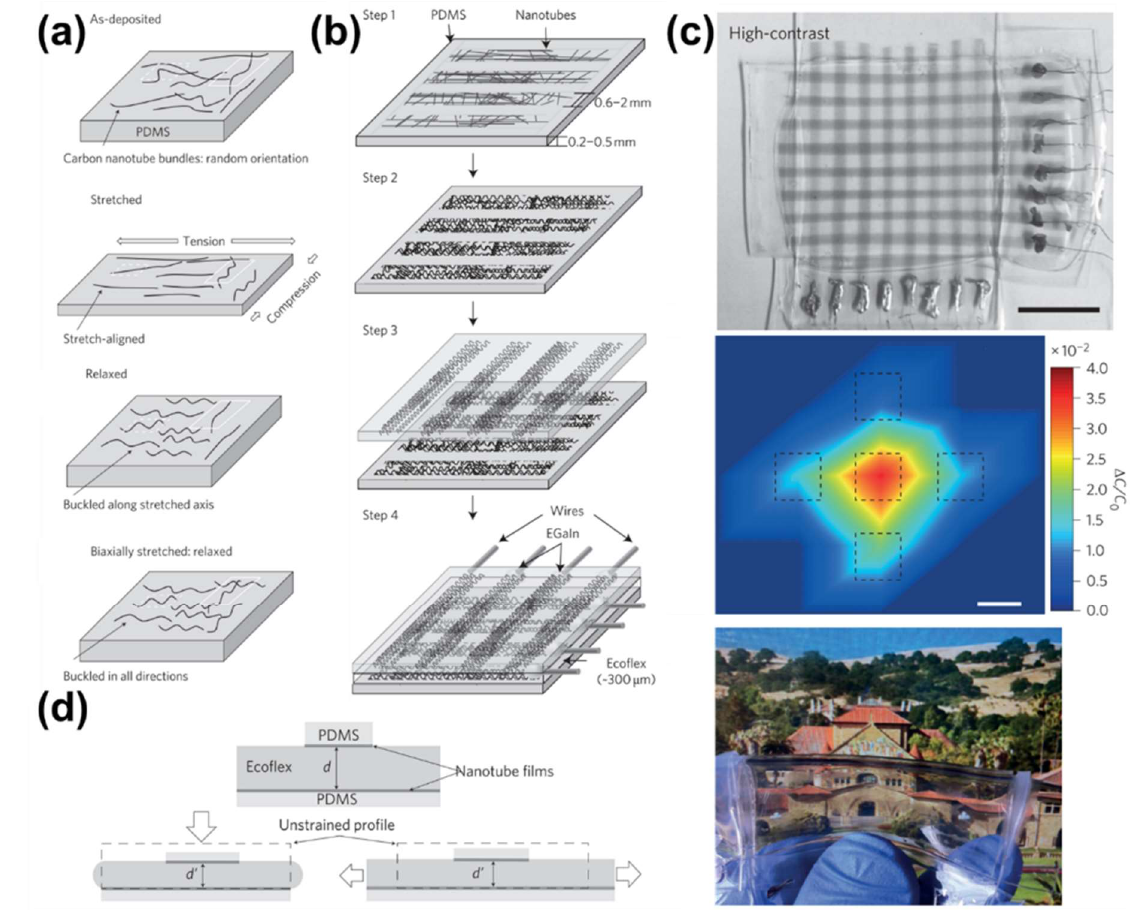
Figure 6. Schematic illustrations of transparent elastic films of CNTs. ( a ) Evolution of morphology of films of CNTs with stretching. ( b ) Processes used to fabricate arrays. Spray-coating through a stencil mask produces lines of randomly oriented nanotubes (step 1). A one-time application of strain and release produces waves in the direction of strain (step 2). A second patterned substrate is positioned (face-to-face) over the first (step 3). The two substrates are bonded using Ecoflex ® silicone elastomer, which, when cured, serves as a compressible dielectric layer (step 4). ( c ) Photograph of the device showing the 64-pixel array of compressible pressure sensors [4]. ( d ) A stretchable capacitor with transparent electrode (top), and the same capacitor after being placed under pressure (left) and being stretched (right) [135] Copyright © 2021, Nature Publishing Group.